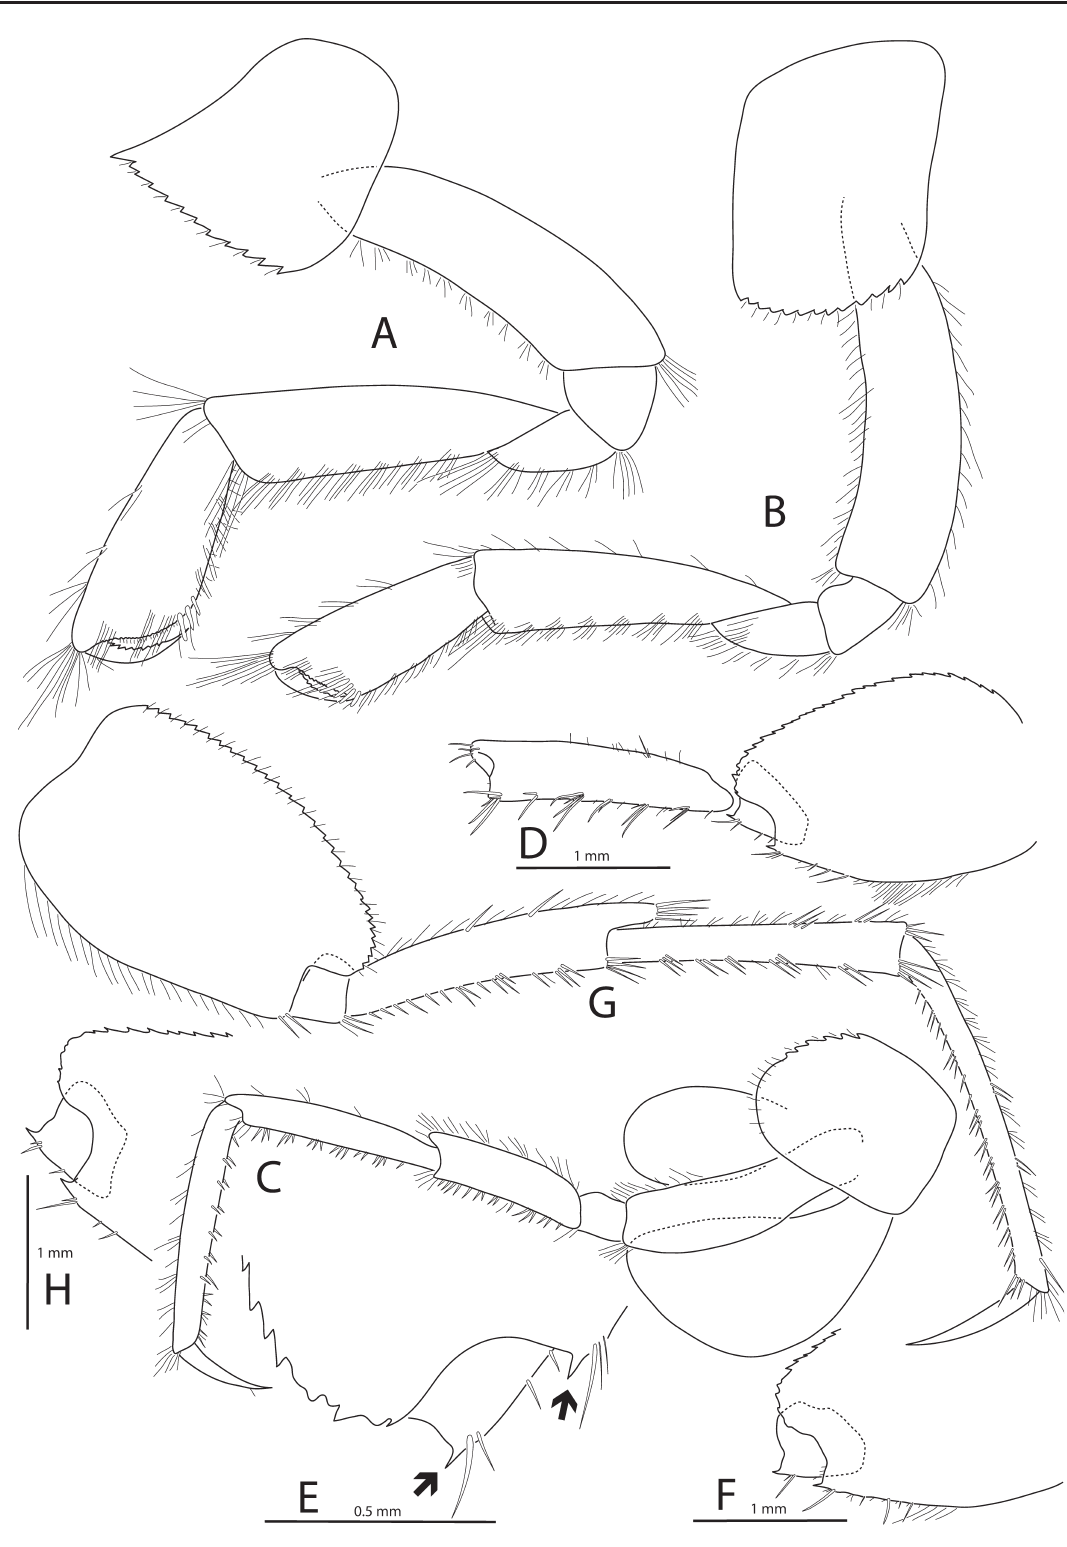
Fig. 11. Halirages stappersi sp. nov., holotype ♂, 20 mm, Kara Sea, RV Belgica stn 132. D, E, F, H . original. A, B, C, G . after Stappers (1911). A . left Gn1. B . left Gn2. C . left P3. D . right P5. E . ischium and tip of basis of right P5. F . ischium and tip of basis of right P6. G . left P7. H . ischium and tip of basis of right